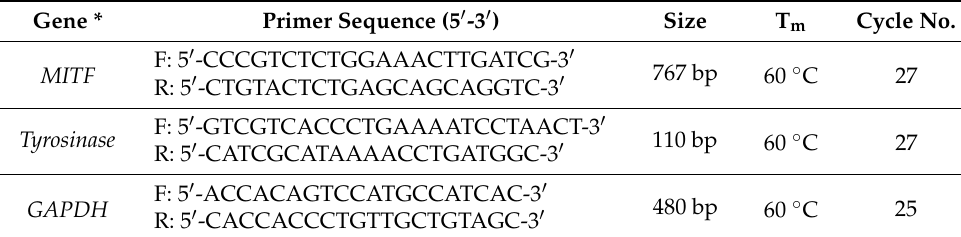
Table 1. Primers and PCR